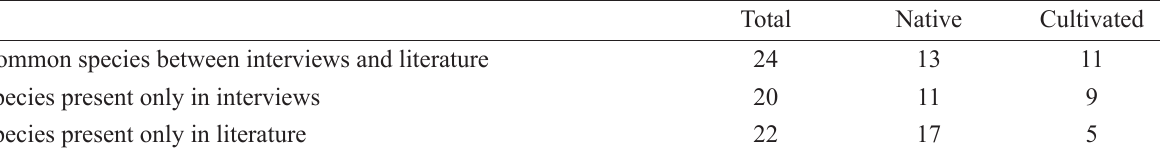
Table 2. Comparative data between plant taxa used as pharmaceuticals referred in interviews and in literature.